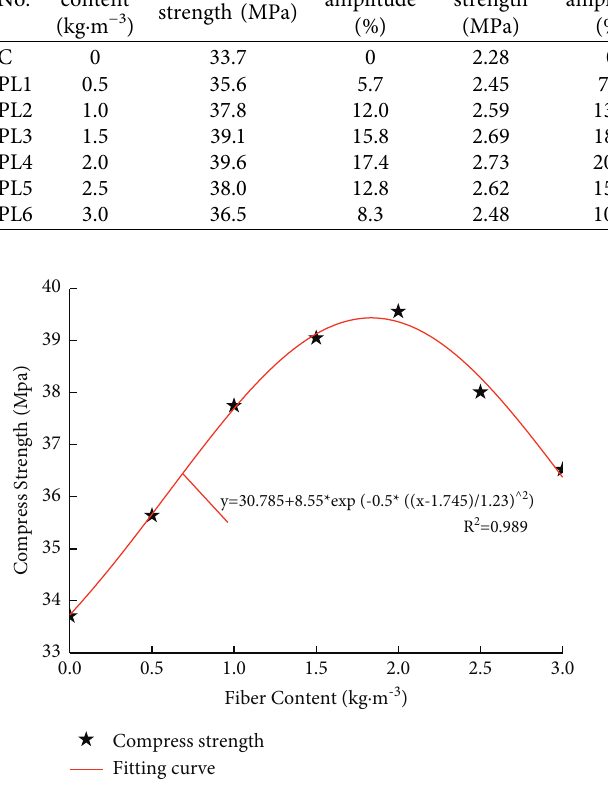
Figure 2: Compressive strength fitting curve.